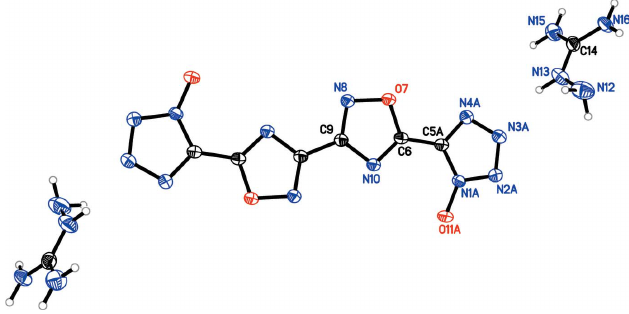
Figure 5 Molecular structure of the major disorder component of 5 , showing the atom-labeling scheme. Displacement ellipsoids are drawn at the 50% probability